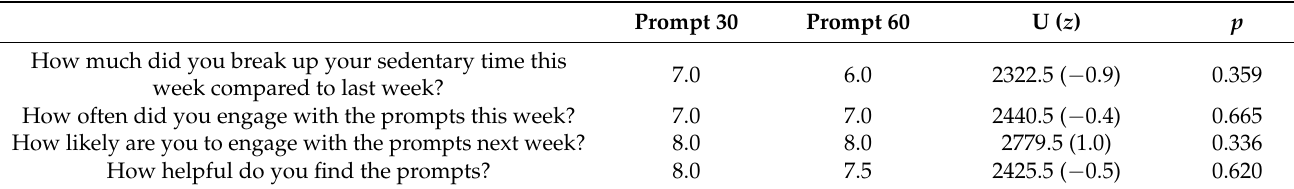
Table 2. Weekly review responses according to intervention